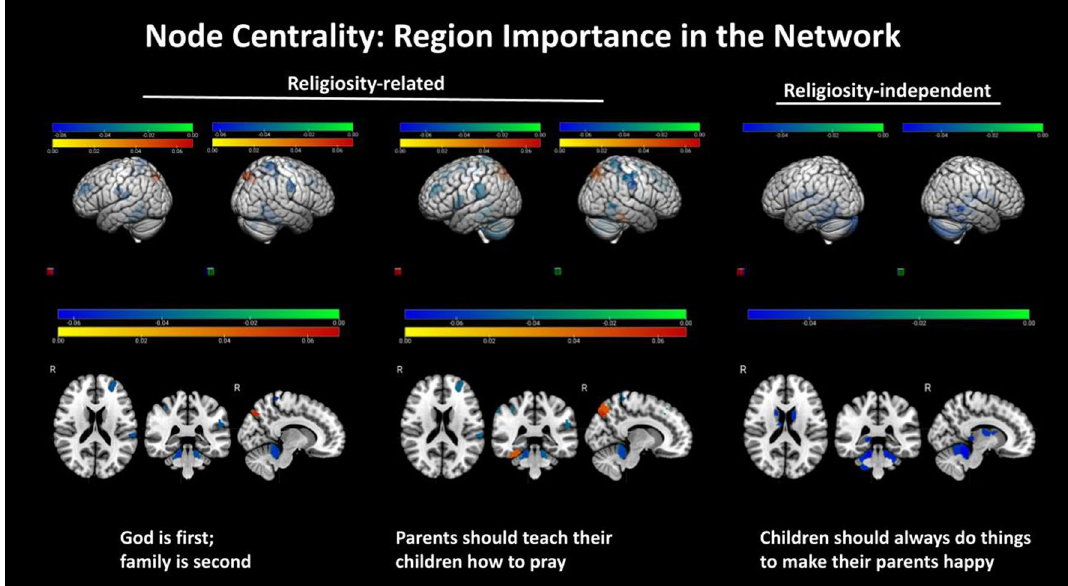
Figure 2. Significant positive and negative associations were estimated, between strength of religious (God is first, family is second, and parents should teach their children how to pray), one religion-independent belief (children should always do things to make their parent happy), and node centrality (regional importance in a network). The colorbars represent the range of positive (yellow–red) and negative (green–blue) standardized regression coefficient values in statistical models that assessed these effects. Two and three-dimensional views of both hemispheres are shown.